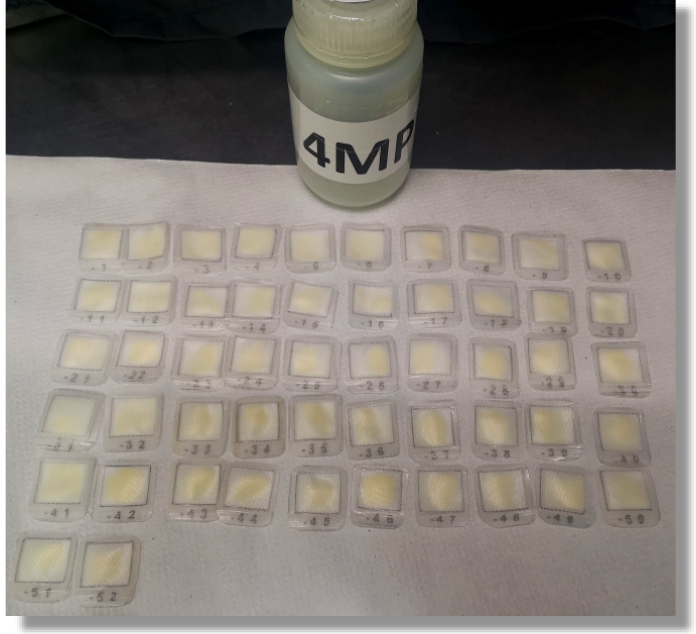
Figure 4. Fmoc deprotection step before coupling. All the tea bags are put in a single container.